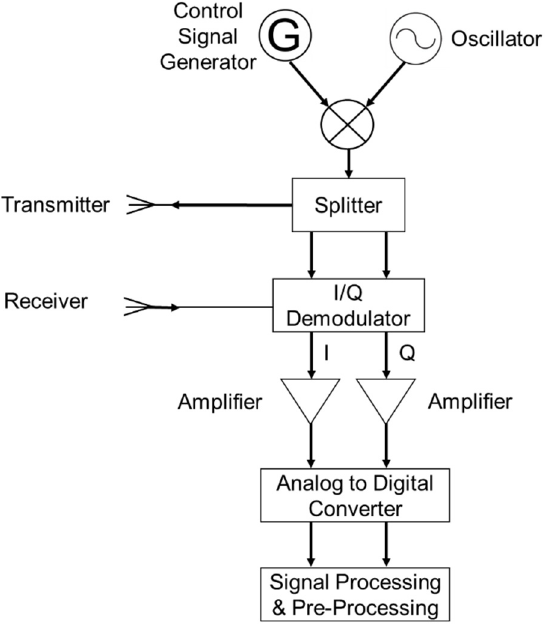
Figure 3. Architecture design of FMCW radar [21] .